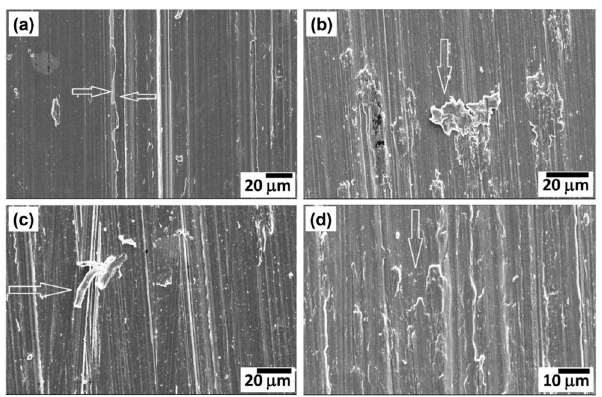
Fig. 16 SEM images of the worn-pin Ti64 surfaces: (a) as-received (load = 100 N, speed = 200 rpm, time = 300 s); (b) as-received (load = 40 N, speed = 800 rpm, time = 1,200 s); (c) quench-aged (load = 100 N, speed = 200 rpm, time = 300 s); (d) quench-aged (load = 100 N, speed = 200 rpm, time = 1,200 s). Reproduced with permission from Ref. [61]. Copyright Elsevier,